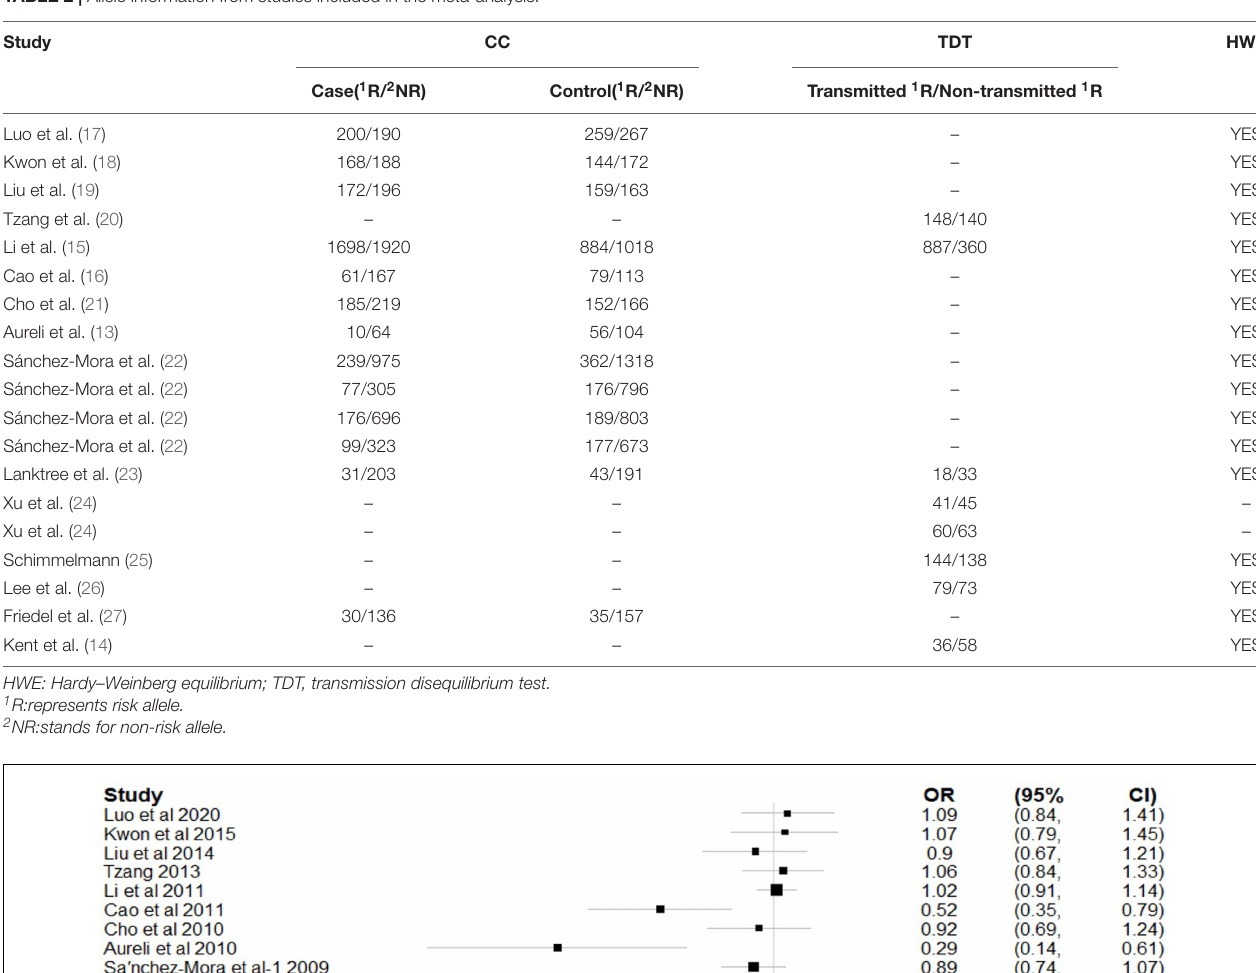
TABLE 2 | Allele information from studies included in the meta-analysis.